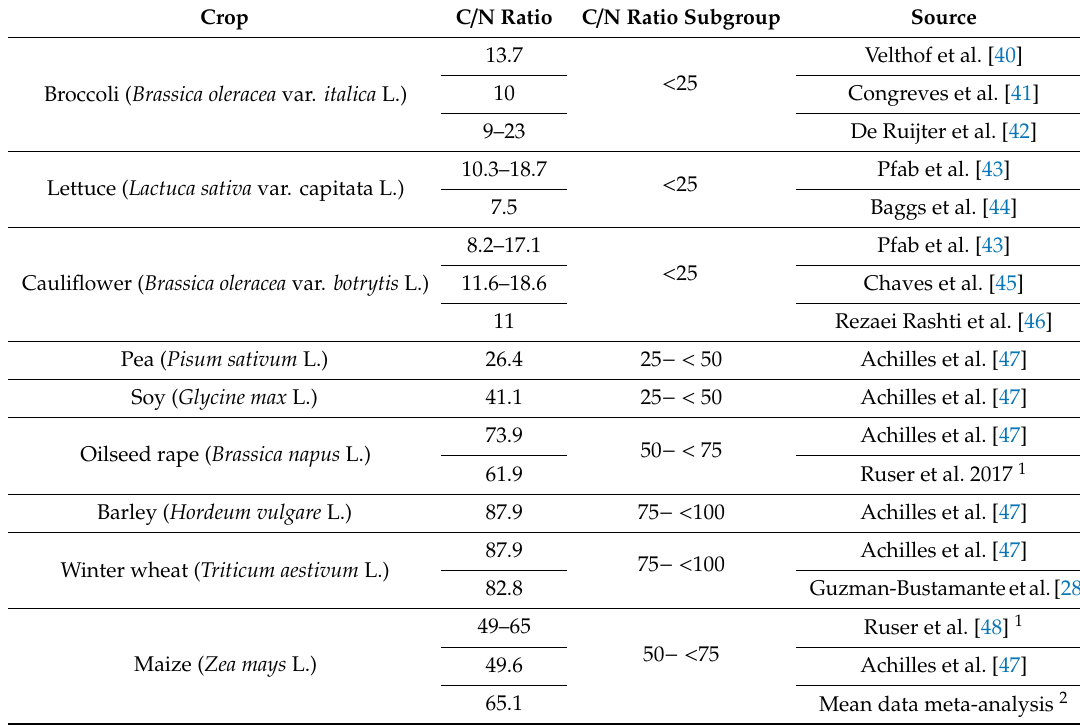
Table 4. C / N ratios of crop residues of broccoli, lettuce, cauliflower, pea, soy, oilseed rape, barley, winter wheat, and maize straw and their allocation into